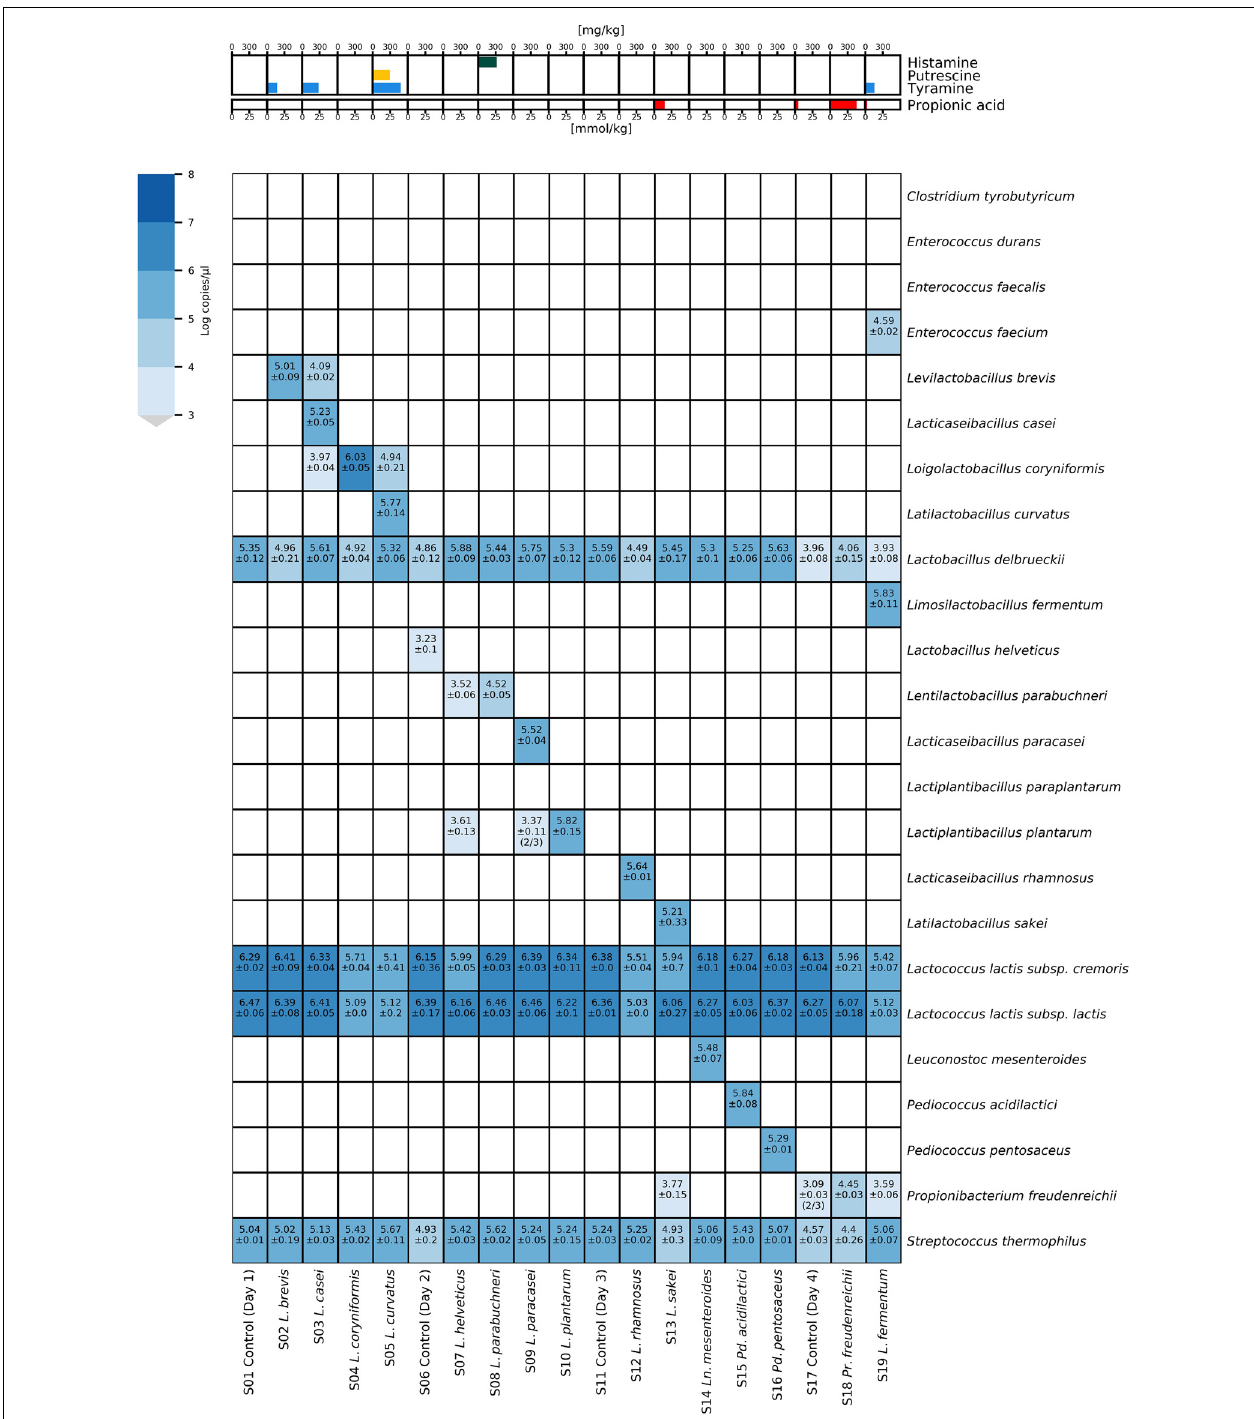
FIGURE 4 | Heatmap of microfluidic HT-qPCR results of Raclette-type model cheese samples produced with adjunct cultures. The results of the chemical analysis of the model cheese are shown in the upper panel, while the results of the HT-qPCR analysis (without preamplification) are shown in a heatmap in the lower panel.